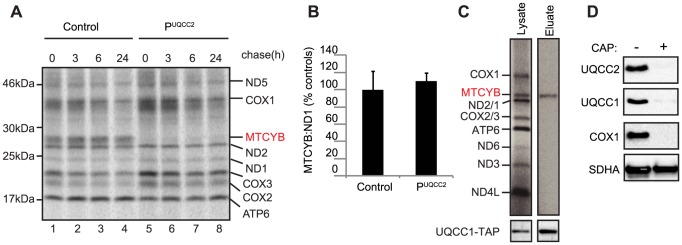
UQCC2 and UQCC1 are involved in cytochrome b translation and/or stability.(A) SDS-PAGE analysis of 35S-methionine-labeled mtDNA-encoded proteins in patient fibroblasts shows a lack of cytochrome b (MTCYB) protein (even at zero hours chase) suggesting a defect in cytochrome b synthesis or its immediate stability. (B) qRT-PCR shows normal expression of cytochrome b (MTCYB) mRNA in patient fibroblasts. (C) Autoradiogram of single step affinity purified UQCC1-TAP with 35S metabolically labeled mitochondrial translation products shows UQCC1 specifically associates with newly synthesized cytochrome b in HEK293 cells. (D) Inhibition of mitochondrial translation in HEK293 cells results in diminished levels of UQCC1, UQCC2, mtDNA-encoded COX1, but does not affect the SDHA subunit of the nuclear encoded complex II.